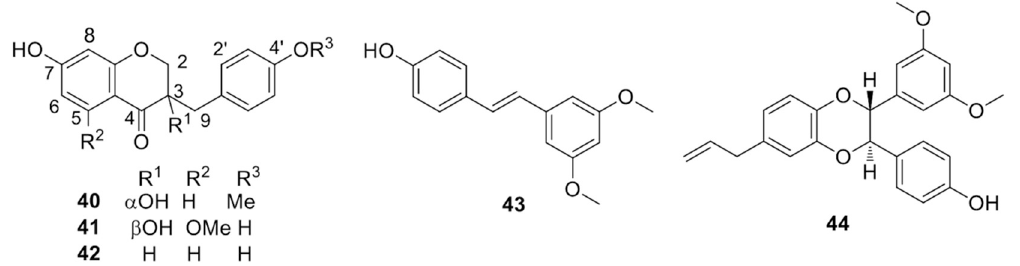
Figure 9. Selected homoisoflavanones and stilbenoids from D. cochinchinensis red resin.